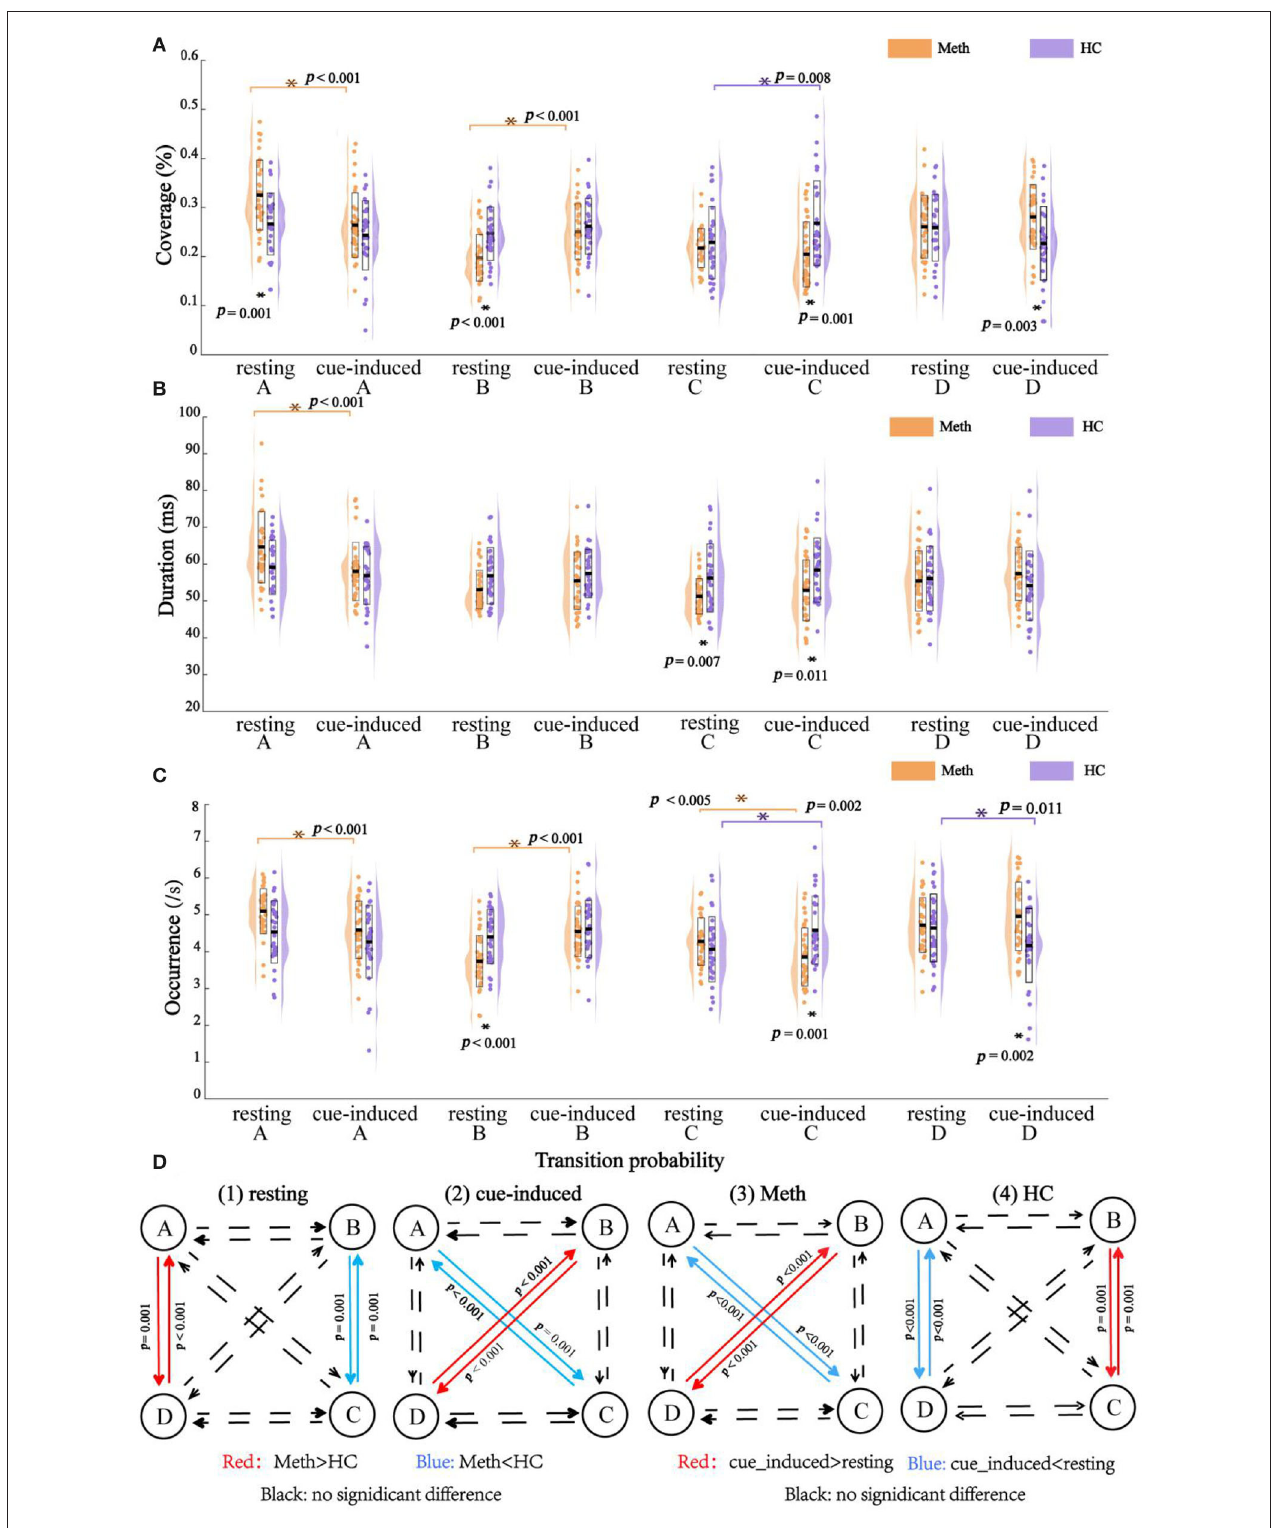
FIGURE 3 | Outcomes of electroencephalography microstates with multiple comparisons. (A) Coverage, (B) duration, (C) occurrence, and (D) transition probability. Dots indicate the microstates feature and outline of violin plot represents the kernel probability density estimation. Significant post-hoc results between groups or between conditions are marked by